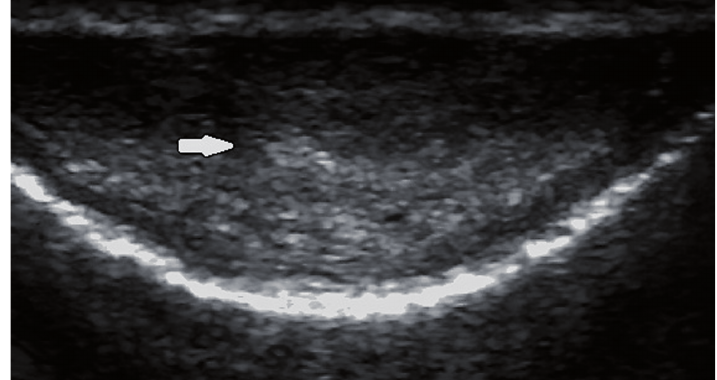
Figure 3 - Transverse US image obtained along the ventral aspect of the penis shows microcalcifications of the intercavernosus septum without associated acoustic shadow (white